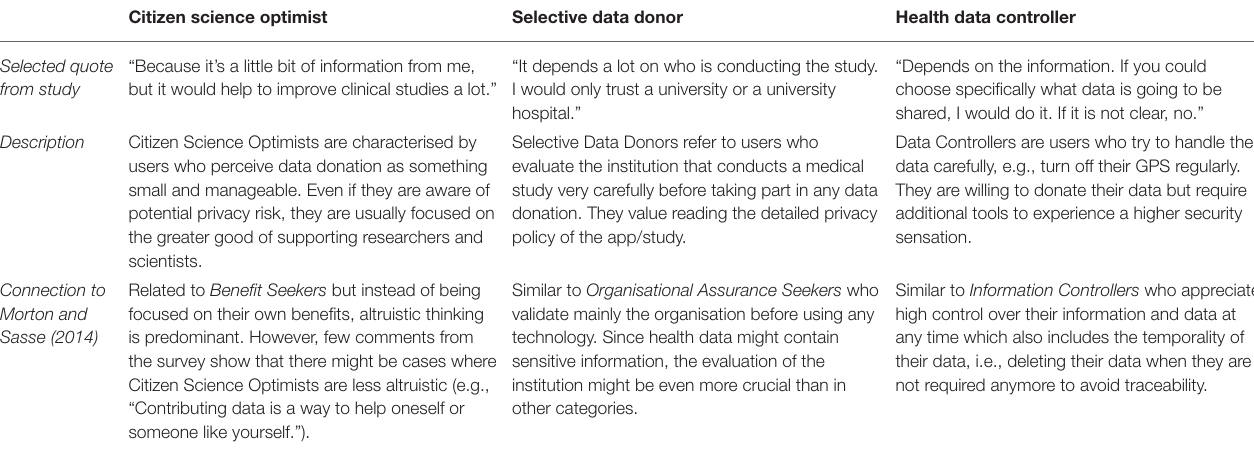
TABLE 11 | Proposed privacy personas in IoT-based health research using citizen science. Citizen science